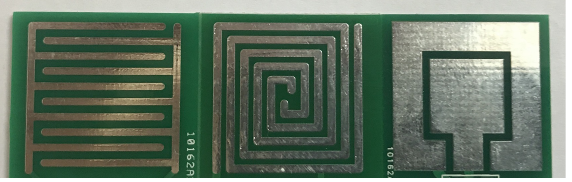
Figure 11. Photograph of prototype